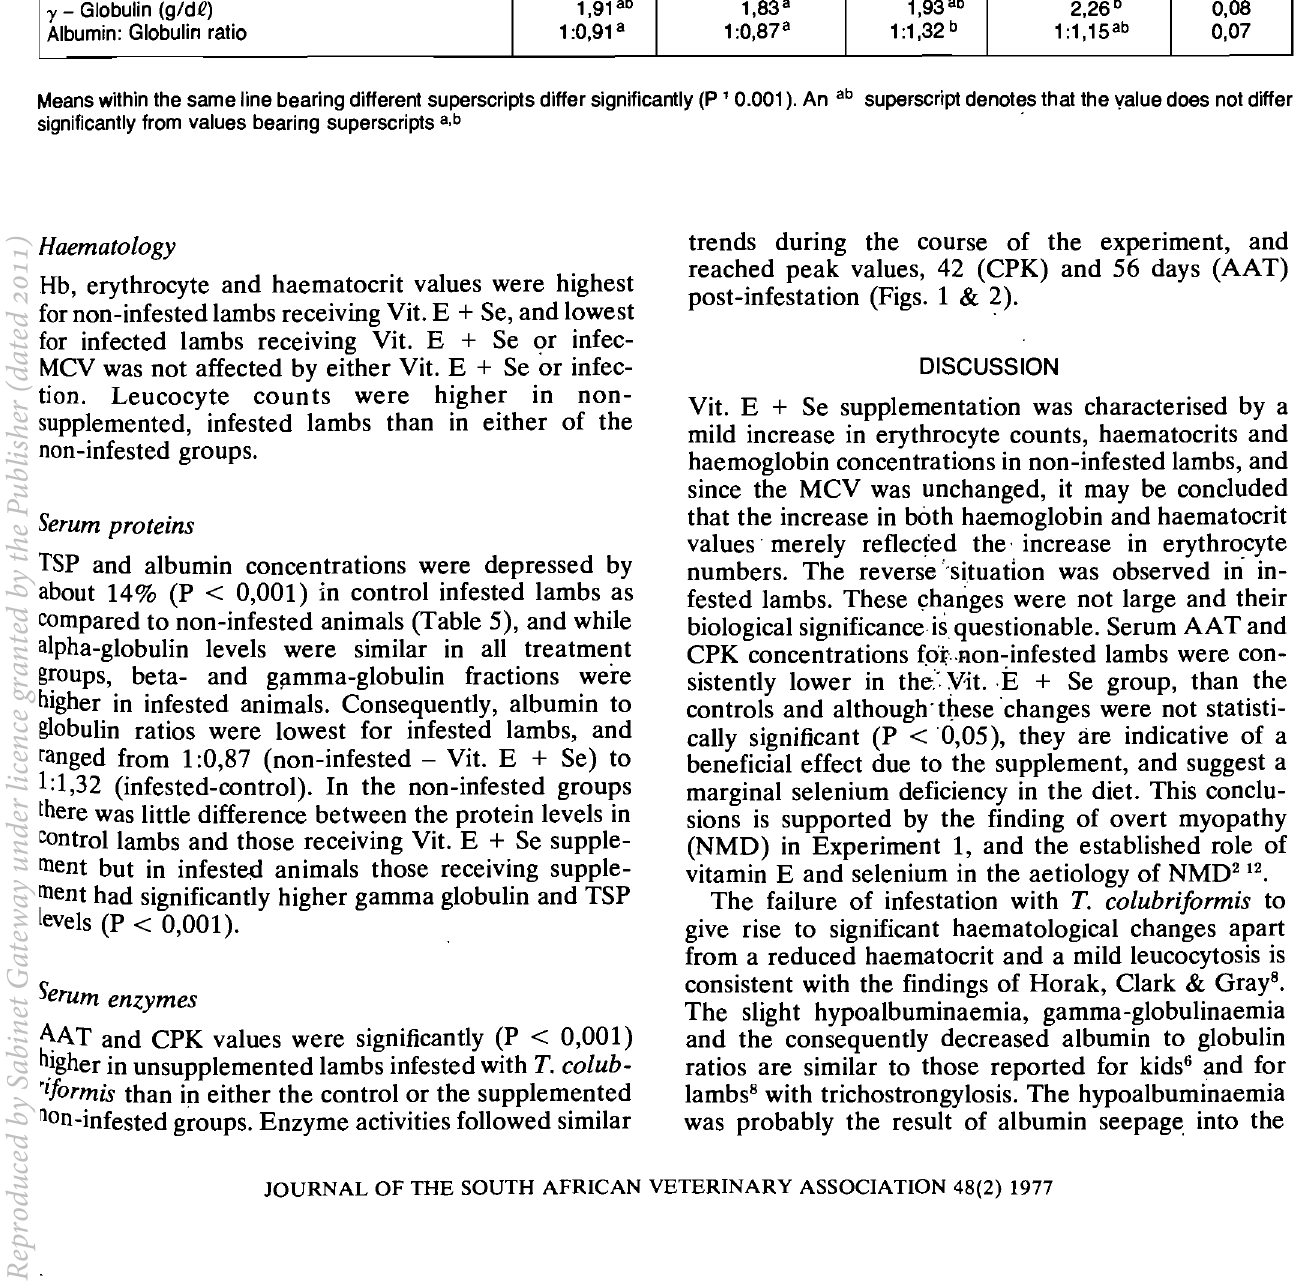
Table 5: MEAN PLASMA PROTEIN LEVELS OF LAMBS IN EXPERIMENT 2 Non-infested